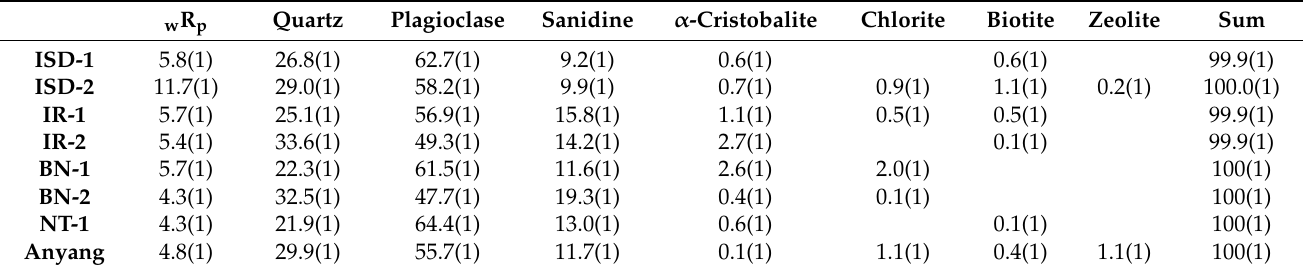
Table 2. Quantitative phase analysis results using Rietveld refinement (in%).